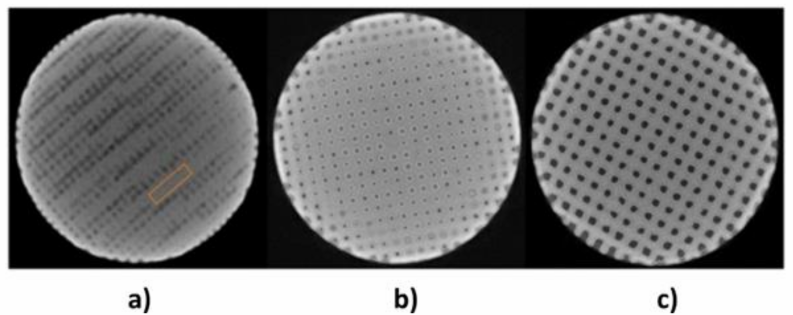
Figure 9. Pore layout and shape: 200 µ m ( a ), 400 µ m ( b ), 600 µ m ( c